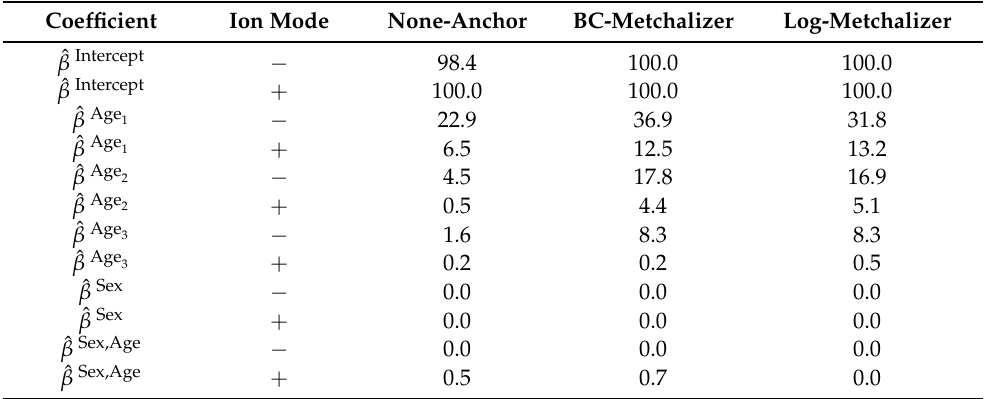
Table 1. The percentage of significant coefficients in the regression model for a given ion mode and normalization